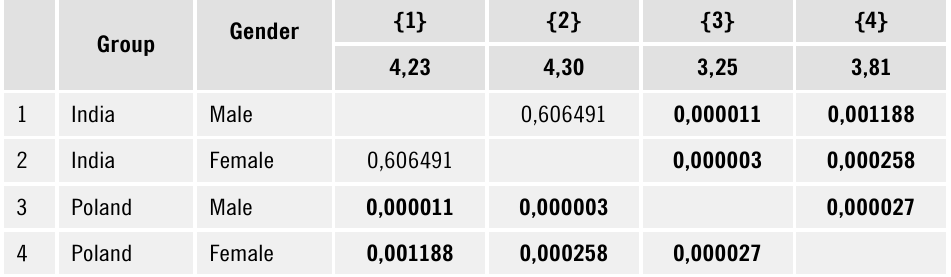
Table 11. Descriptive statistics of post-hoc Duncan difference test between respondents of different gender and nationalities in the GC